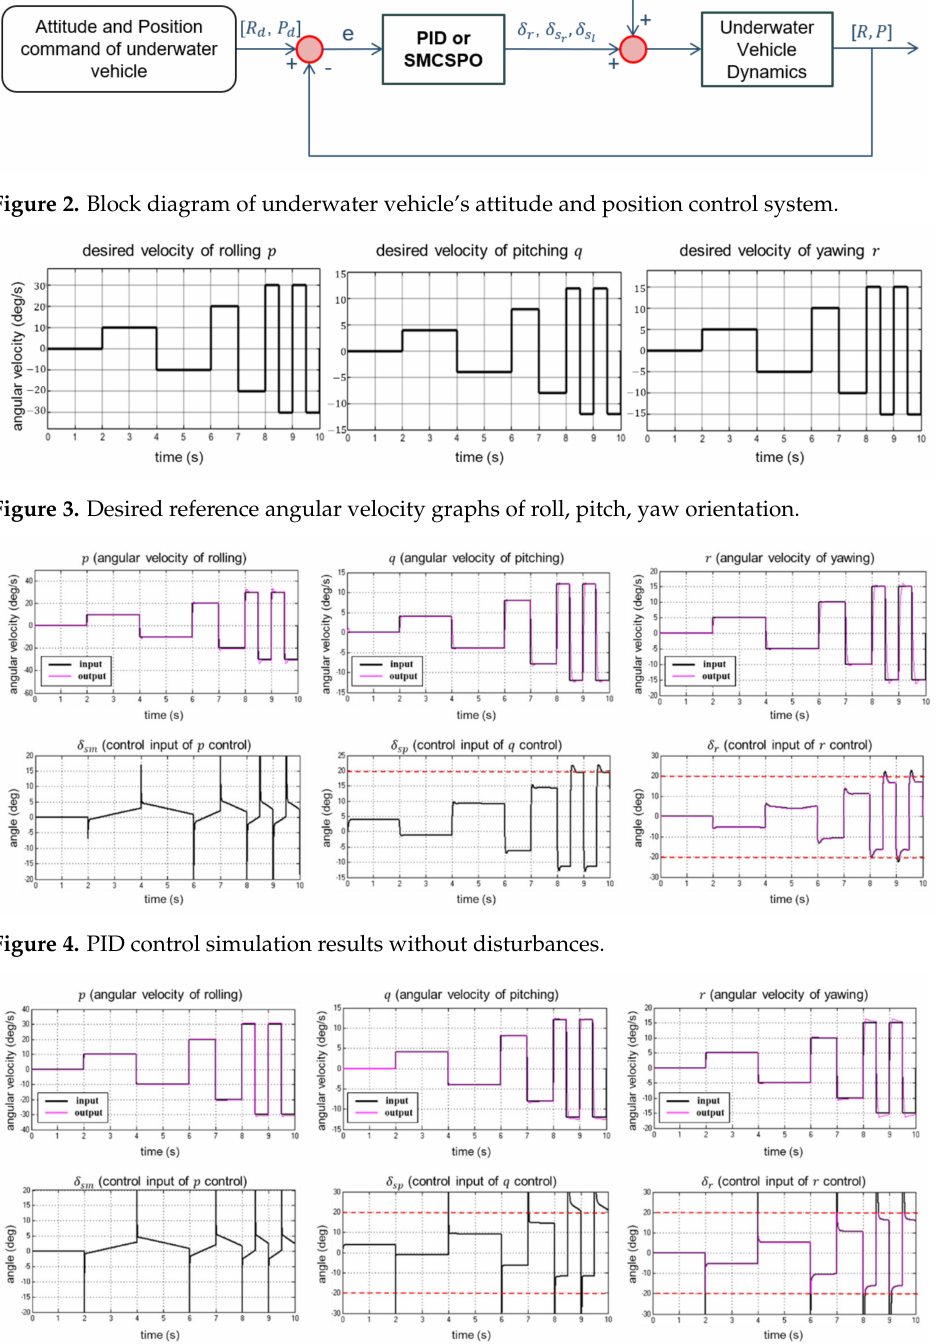
Figure 5. SMCSPO control simulation results without